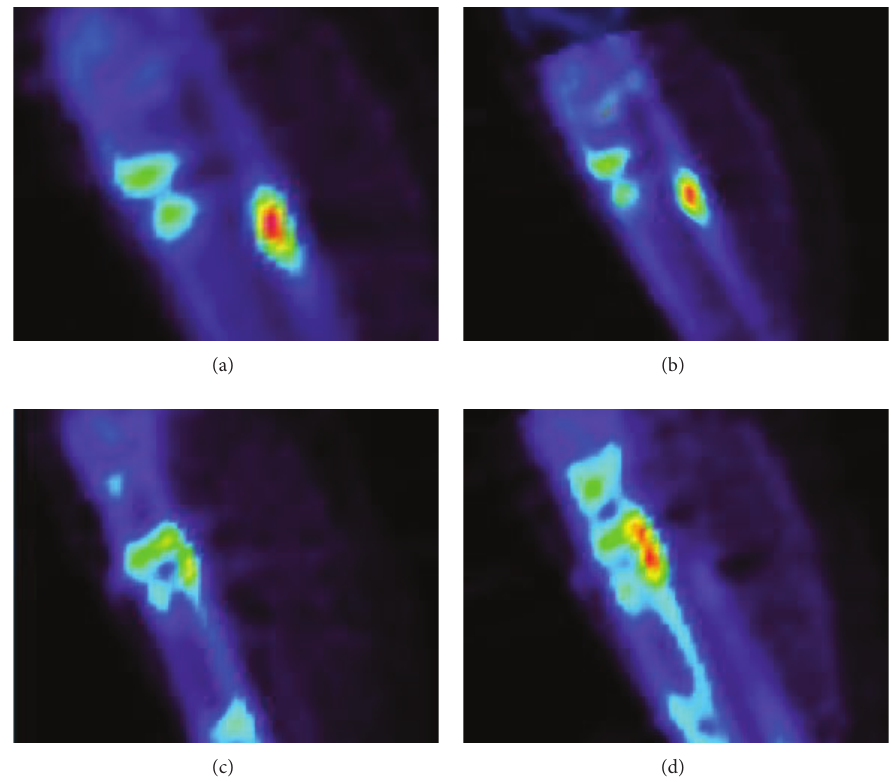
Figure 5: A sagittal section for Patient 4 of the PET at 52 days (a) and at 94 days (b) showing the fibula. A sagittal section of the PET at 52 days (c) and at 94 days (d) showing the tibia. The remodeling of the tibia in (d) seems to be uneven.